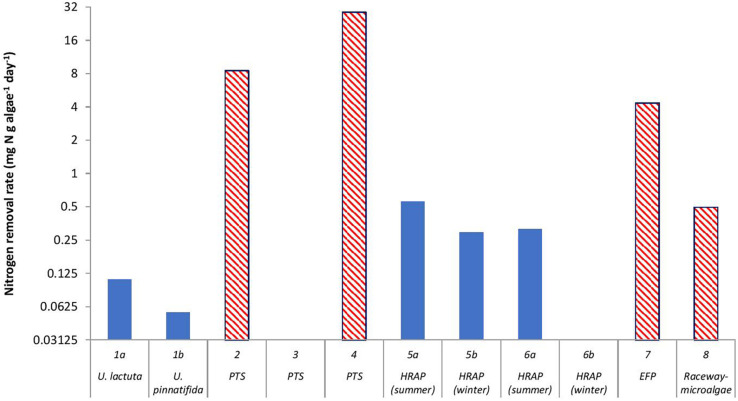
Nitrogen removal rate by algae (mg N g algae dry weight–1 day–1) in a recirculating aquaculture system. The algal reactor in Study 1 (Cahill et al., 2010) used two algal species, Ulva lactuca and Ulva pinnatifida. Study 2 (Valeta and Verdegem, 2015), Study 3 (Huang et al., 2013), and Study 4 (SustainAqua, 2009) used a periphyton turf scrubber (PTS), Study 5 (Pagand et al., 2000), and Study 6 (Deviller et al., 2004) used high-rate macroalgal based algal ponds (HRAP), Study 7 (Gál et al., 2003) used an extensive fish pond (EFP), and Study 8 (Li et al., 2019) used outdoor microalgal based raceway as methods to integrate algae in the RAS. The red bars with a diagonal pattern represent microalgae and the blue bars represent macroalgae. Information on algae for Studies 3 and 6b were not part of the design of those studies, thus, were not provided by those authors.